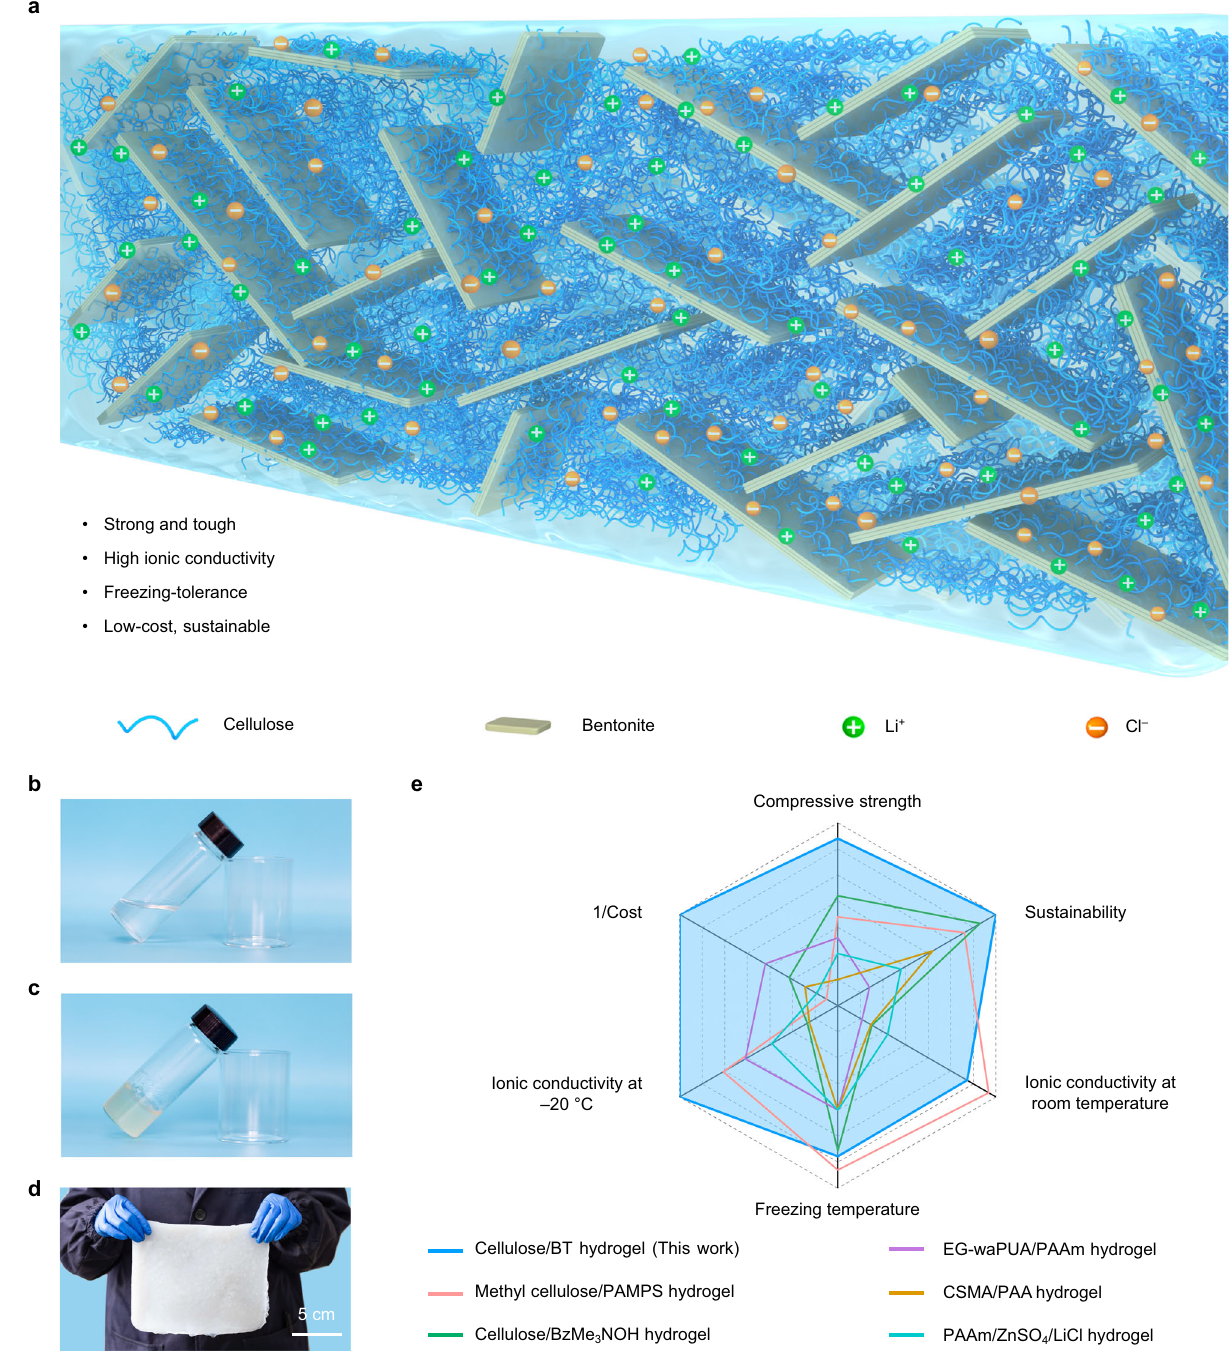
Fig. 1 Fabrication of cellulose/BT hydrogels. a Schematic of the proposed microstructure for the cellulose/BT hydrogels. b , c Photographs of the cellulose solution and hydrogel. d Optical image of the large-sized Ion-CB hydrogel. e A comprehensive comparison between cellulose/BT hydrogel of this work and previously reported conductive hydrogels in terms of compressive strength, sustainability, cost, freezing temperature, and ionic conductivity at room temperature and − 20 °C including methyl cellulose/poly (2-acrylamido-2-methylpropanesulfonic acid) (PAMPS) hydrogel 37 , cellulose/ benzyltrimethyl ammonium hydroxide (BzMe 3 NOH) hydrogel 38 , ethylene glycol-waterborne anionic polyurethane acrylates (EG-waPUA)/polyacrylamide (PAAm) hydrogel 39 , methacrylated chondroitin sulfate (CSMA)/polyacrylic acid (PAA) hydrogel 40 , and polyacrylamide (PAAm)/ZnSO 4 /LiCl hydrogel 41 cross-linking density, while the green-colored region indicates the characteristic peak of BT located at 7.2° shifts to 5.6° in the Ion- opposite. It is surprising to fi nd that they deliver similar cross- CB hydrogel, suggesting an increase of the interlayer spacing of linking densities, both of which are much higher than that BT resulted from cellulose intercalation into BT 24,25 . Figure 2j, k compares the 2D Raman mapping images of Ion-CB hydrogels obtained for the ionic conductive cellulose (Ion-C) hydrogel prepared with and without cross-linker 1,4-Butanediol diglycidyl prepared in absence of BT (Supplementary Fig. 9), demonstrating ether (BDE), in which the blue-colored region indicates higher that BT contributes a lot in enabling high cross-linking density.